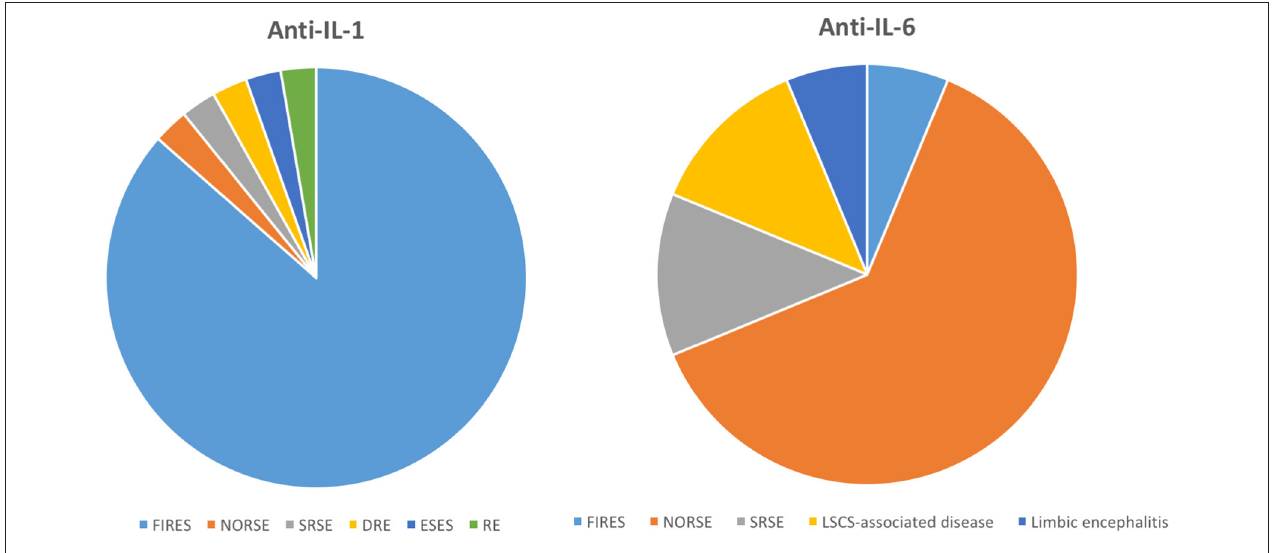
FIGURE 8 | Use of anakinra and tocilizumab in epilepsy, data from the